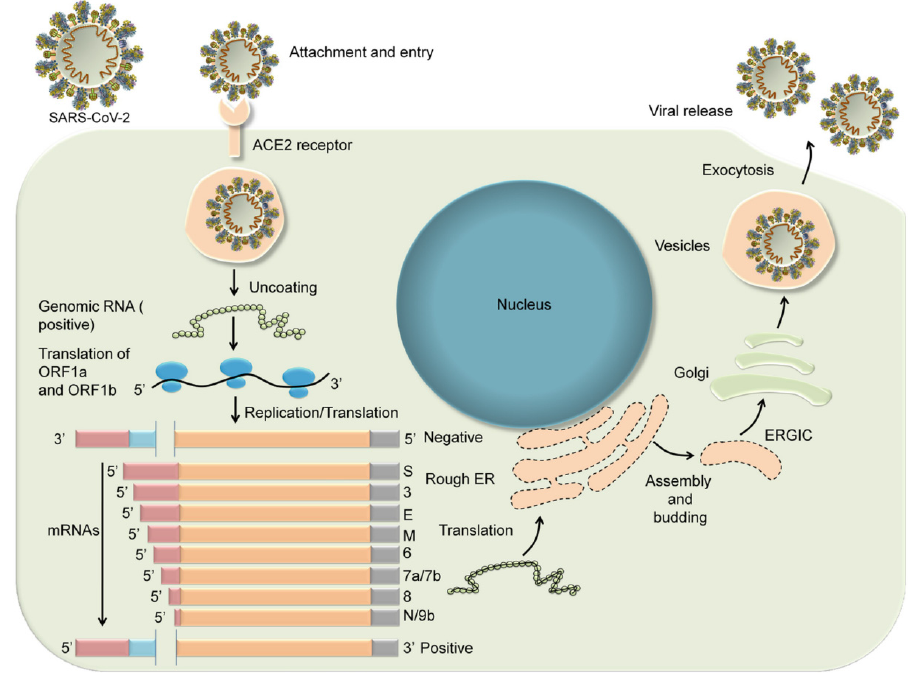
Figure 1. Entry and replication of SARS-CoV-2 in host cells. Reproduced with kind permission from Shailendra Saxena of King George’s Medical University (KGMU), Lucknow, India [27].